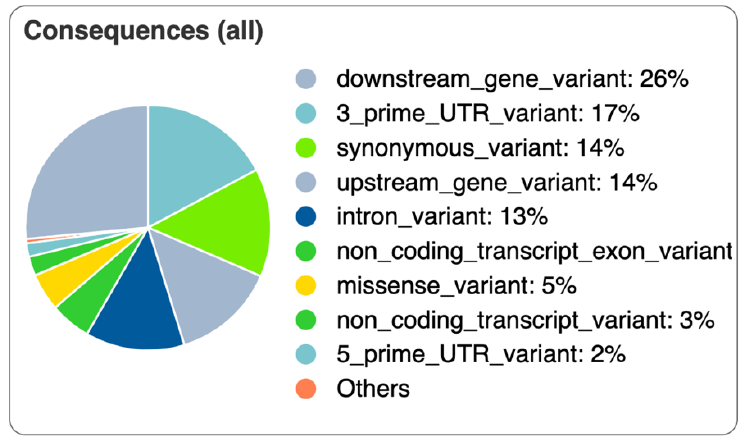
Figure 7. Consequences of all variants identified the articular cartilage and growth plate transcrip- tomes between normal and affected broilers using the VEP tool. tomes between normal and affected broilers using the VEP